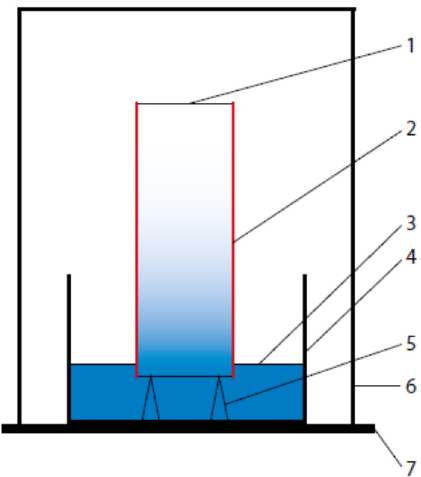
Figure 1. Transient state aggressive ion diffusion test diagram; 1—tested specimen; 2—protecting coating (epoxy resin); 3—penetrating solution; 4—vessel with penetrating solution; 5—specimen supports; 6—protecting cover; 7—base.